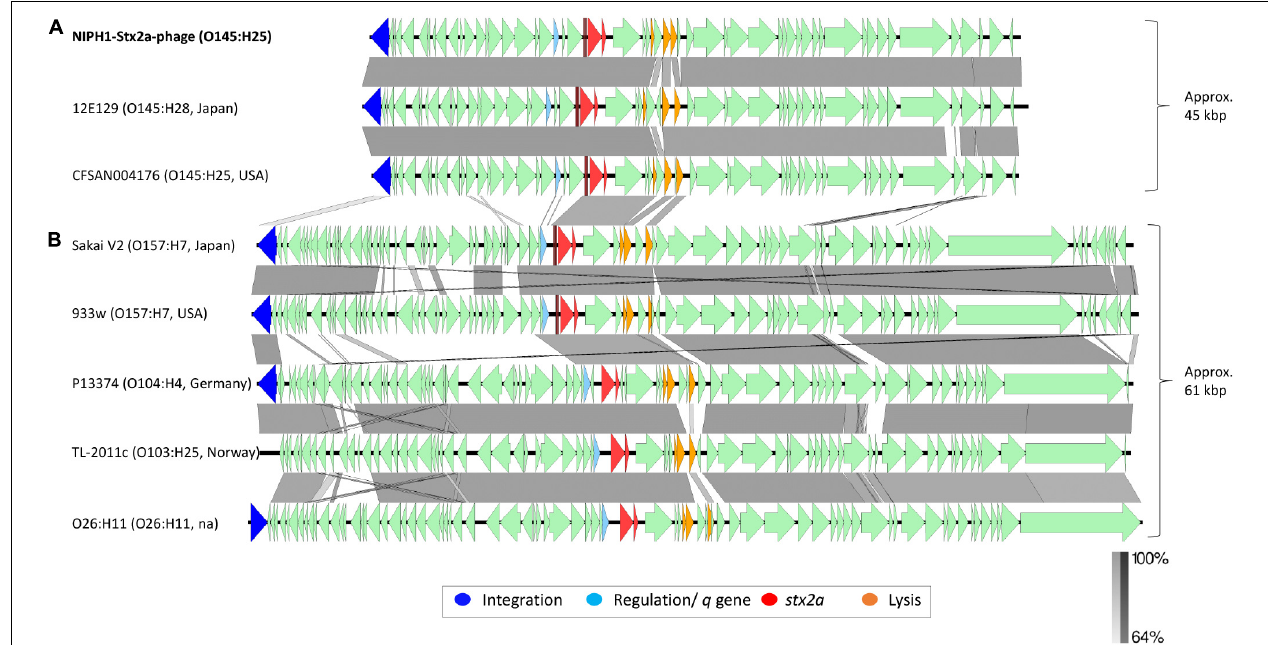
FIGURE 3 | Comparison of the genome structure of the O145:H25 NIPH1-Stx2a-phage with Stx2a phages from STEC of various serotypes. The alignment shows separation of the Stx2a phages in two groups, (A) one of approximately 45 kbp size and (B) the other of 61 kbp size. The genomic organization of genes is similar, with gene for integration followed by regulation of tRNAs, stx2a , lysis, and structural genes. There are large differences at the gene level between the two Stx2a phage groups and smaller differences within the groups. Left scale bar shows percent sequence homology.